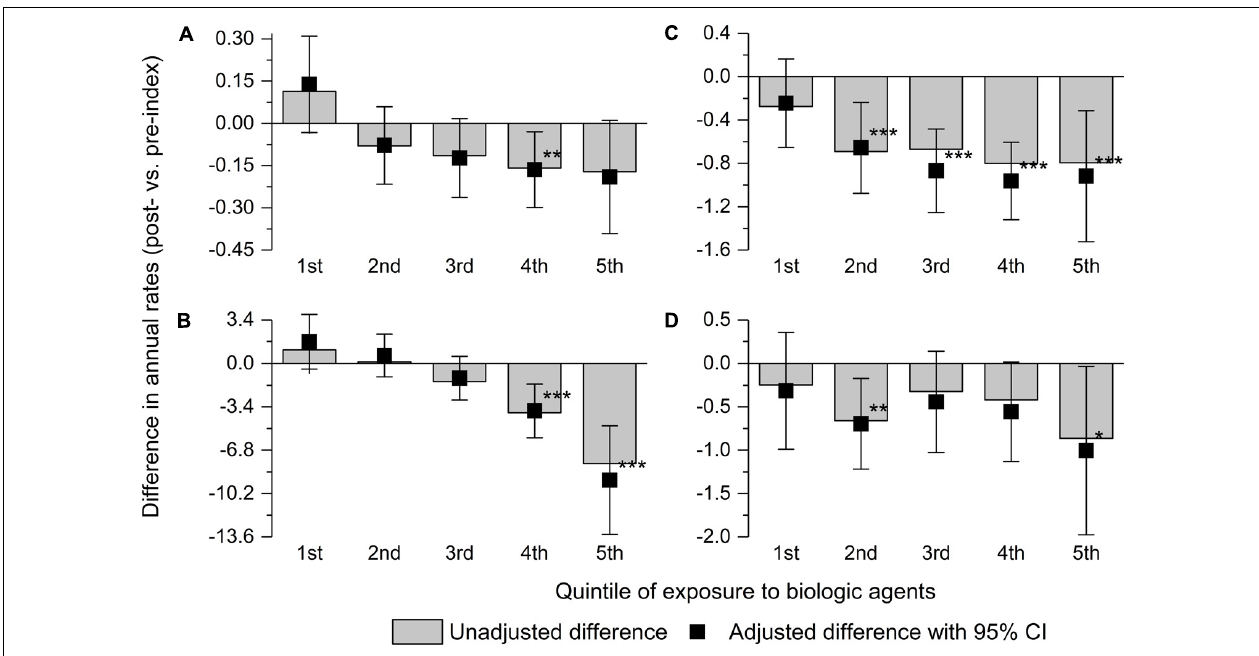
FIGURE 1 | Adjusted and unadjusted difference between the post-index and pre-index periods in annualized rates of surgery for Crohn’s disease (A) , other hospitalizations for Crohn’s disease (B) , and consumption of steroids (C) and antibiotics (D) by the quintile of total exposure to biologic agents. Error bars indicate 95% confidence intervals. ∗ 0.05 > p ≤ 0.01; ∗∗ 0.01 > p ≤ 0.001; and ∗∗∗ p <